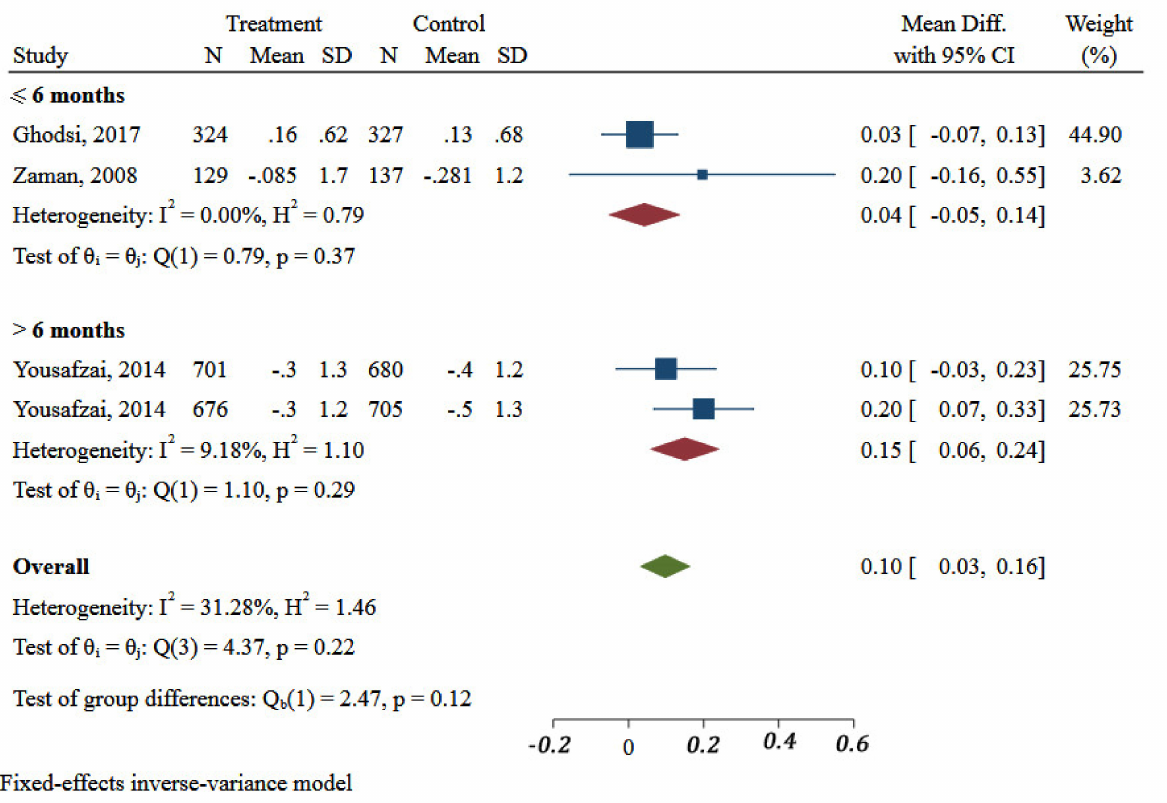
Figure 5. Impact of different community-based nutrition intervention duration on Weight-for-Age Z-score of children under 5 in Eastern Mediterranean